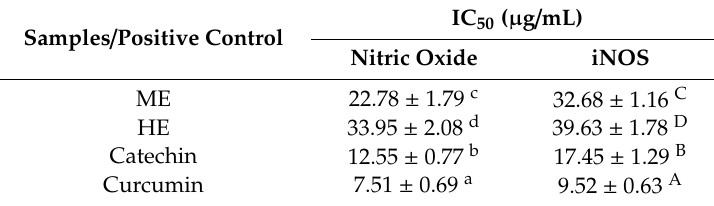
Table 2. The IC 50 of nitric oxide and iNOS production induced by combination with LPS-IFN- γ in RAW 264.7